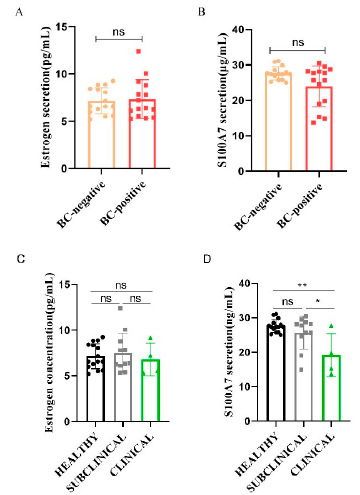
Figure 1. Difference between estrogen and S100A7 abundance in milk. ( A ) The difference of estrogen abundance in the BC-negative and BC-positive groups; ( B ) the difference of S100A7 abundance in the BC-negative and BC-positive groups; ( C ) the difference of estrogen abundance in HEALTHY, SUBCLINICAL and CLINICAL groups; ( D ) the difference of estrogen abundance in HEALTHY, SUBCLINICAL and CLINICAL groups; BC = bacterial culture; HEALTHY = healthy samples; SUB- CLINICAL = subclinical mastitis samples; CLINICAL = clinical mastitis samples; ns: p > 0.05; *: p < 0.05; **: p < 0.01. Different colors stand for different groups.